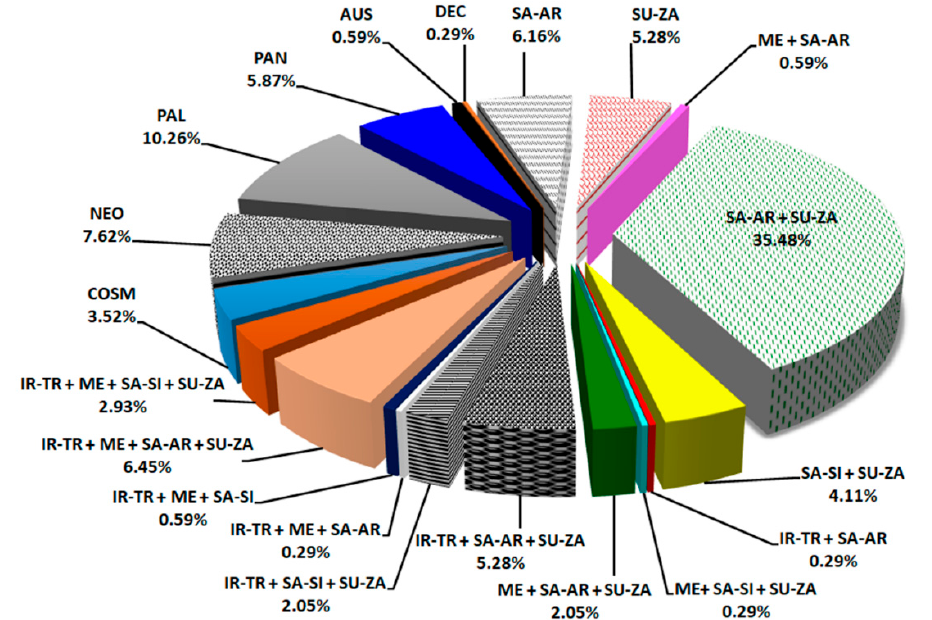
Figure 5. Phytogeographical analysis of the recorded species in Jabal Fayfa. For the abbreviations see Appendix A. Appendix